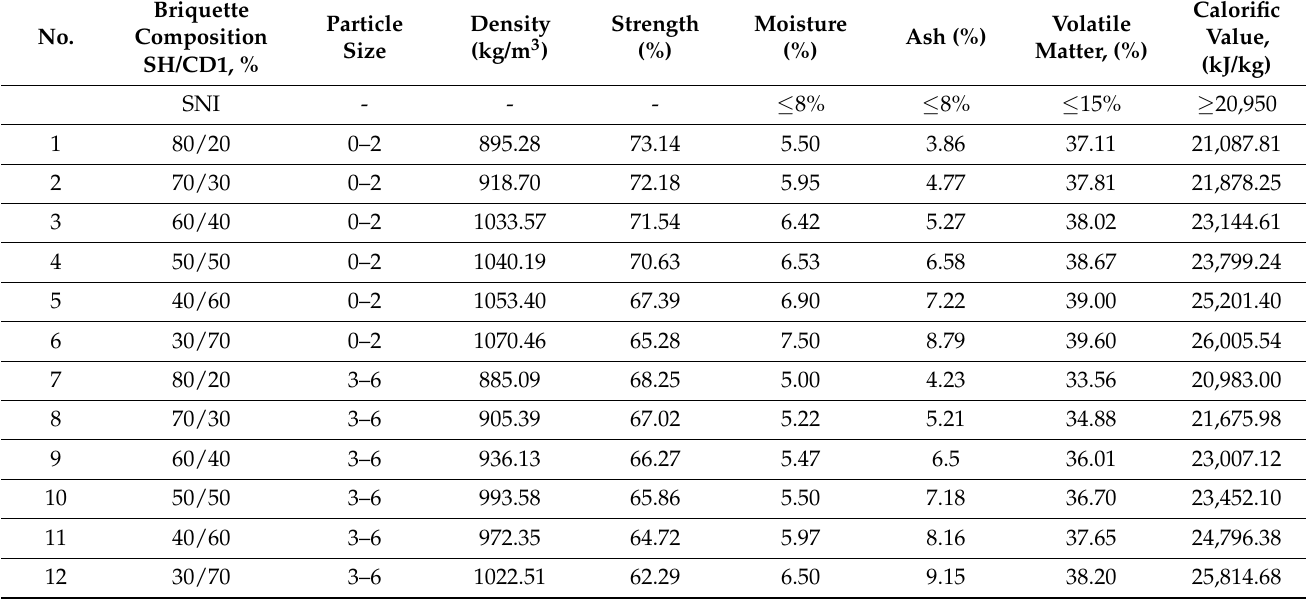
Table 4. The results of the analysis of briquettes (sunflower husk and Shubarkul coal dust).